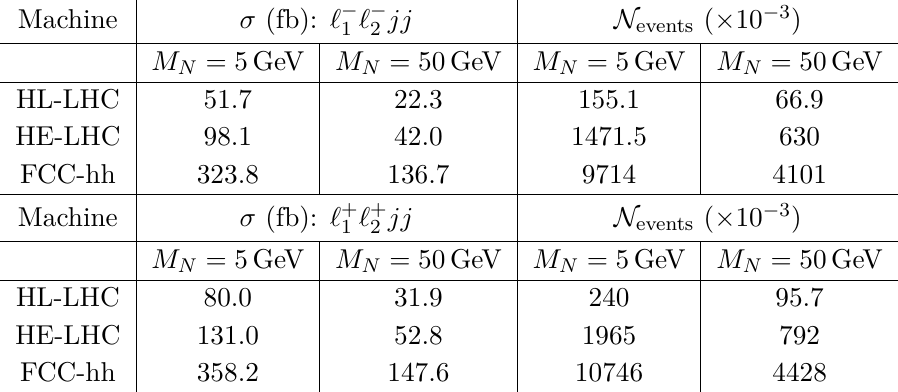
‘ − ( q 0 ¯ q ) + and pp → 1 2 √ s = 27 TeV, peak L int = 15 ab − 1 ), and